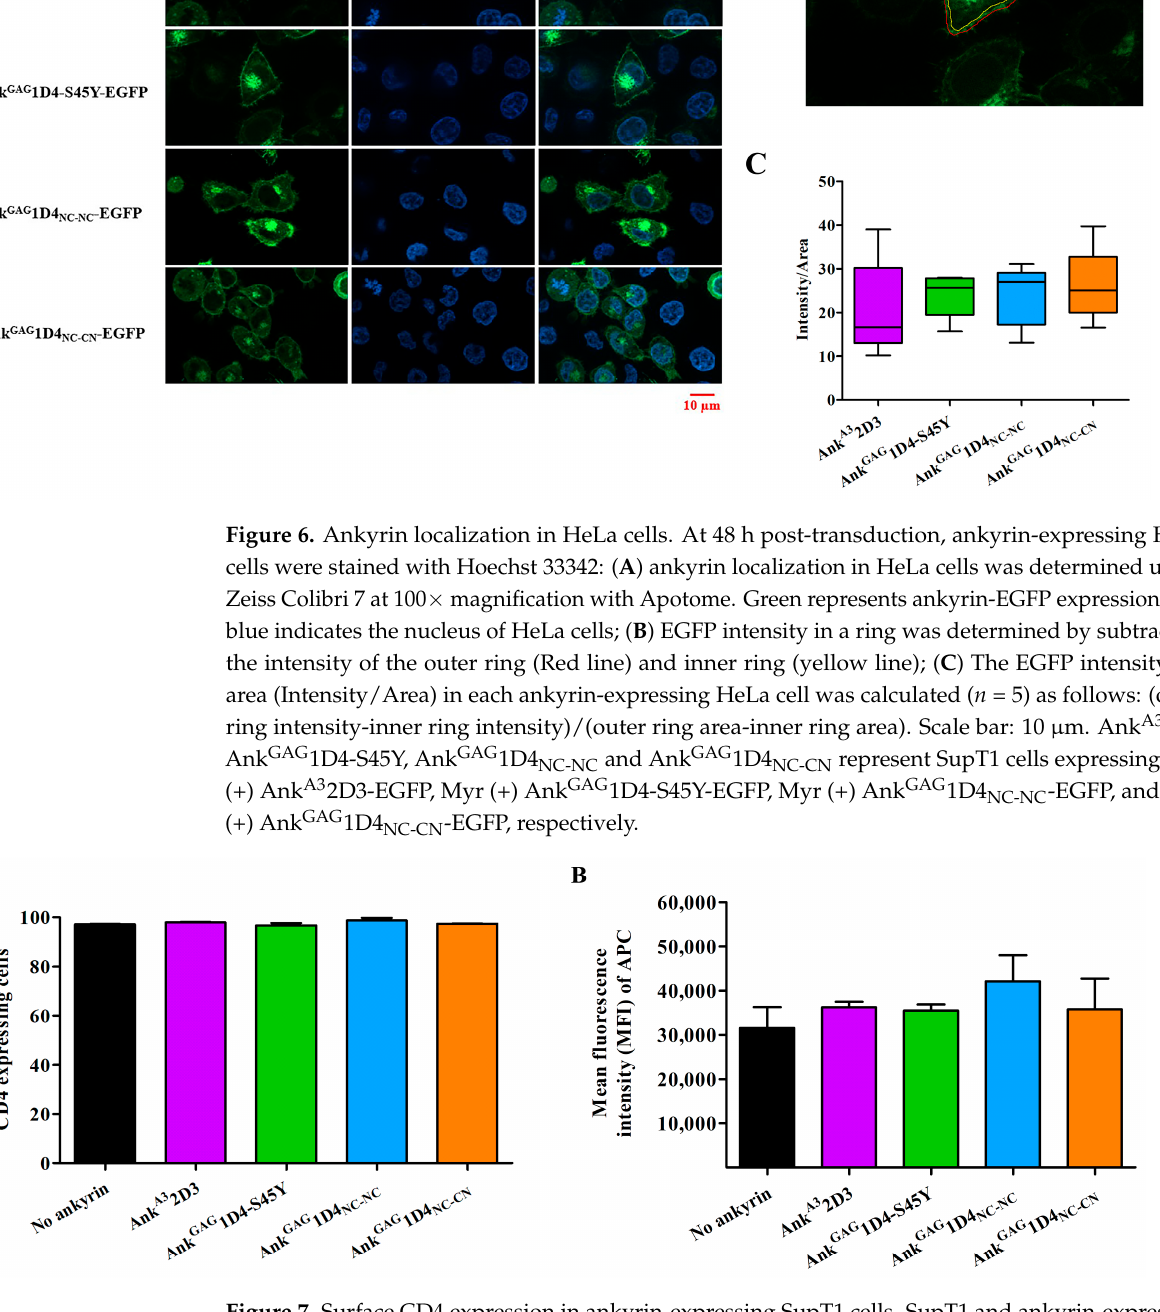
Figure 7. Surface CD4 expression in ankyrin-expressing SupT1 cells. SupT1 and ankyrin-expressing SupT1 cells were stained with APC-conjugated anti-human CD4 antibody: ( A ) Percentage of CD4 positive cells; and ( B ) The MFI of APC was determined by flow cytometry. The data represent the mean ± SD of the triplicate experiment. Ank A3 2D3, Ank GAG 1D4-S45Y, Ank GAG 1D4 NC-NC and Ank GAG 1D4 NC-CN represent SupT1 cells expressing Myr (+) Ank A3 2D3-EGFP, Myr (+) Ank GAG 1D4- S45Y-EGFP, Myr (+) Ank GAG 1D4 NC-NC -EGFP, and Myr (+) Ank GAG 1D4 NC-CN -EGFP, respectively.